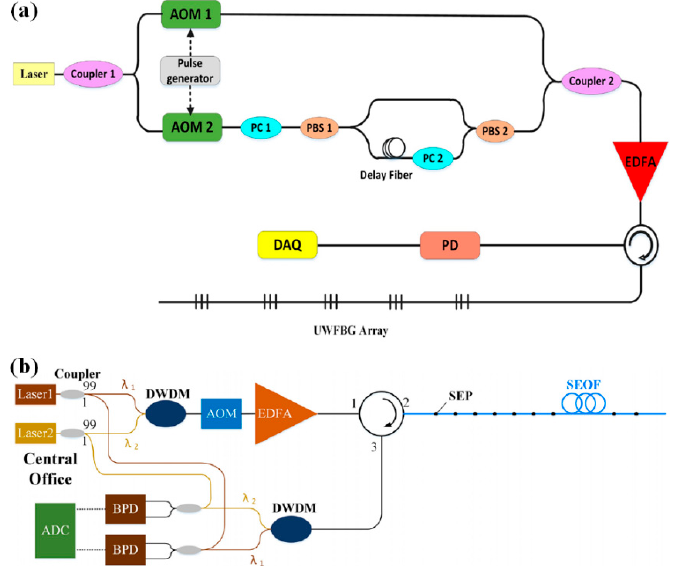
Figure 13. Representative scheme for polarization noise suppression: ( a ) orthogonal polarization scheme [16]; ( b ) multi ‐ parameter scheme [66].